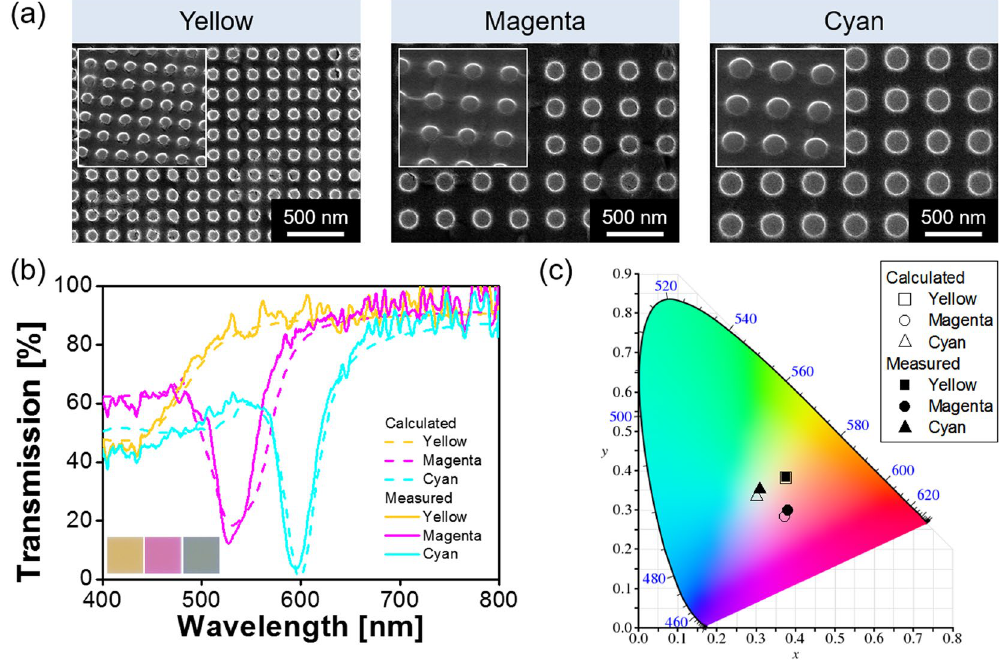
Figure 2. ( a ) SEM images of the fabricated metasurfaces for yellow, magenta, and cyan colors, from left to right. The scale bar is equivalent to 500 nm. ( b ) Calculated (dashed) and measured (solid) transmission characteristics for the three primary subtractive colors of yellow, magenta, and cyan. The inset shows the generated color output for a single pixel. ( c ) The corresponding color outputs are mapped in the CIE 1931 chromaticity